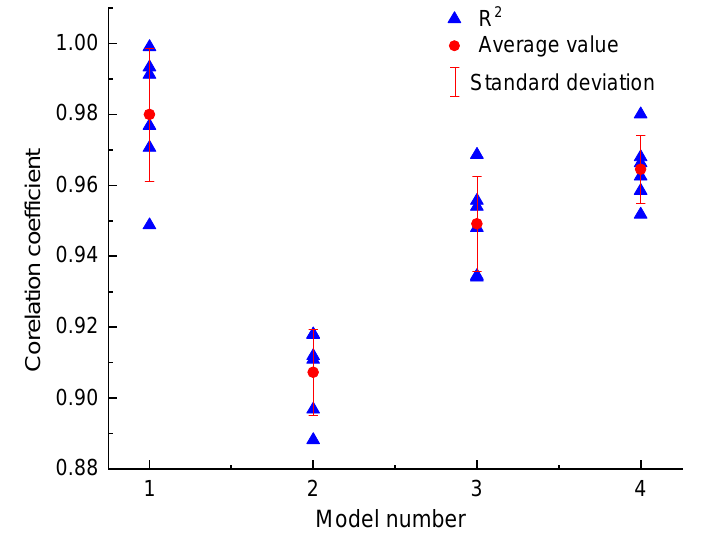
Figure 10. Fitting curves with four functions for based on in situ shear test data. ( a ) Asymmetric sigmoid function; ( b ) symmetric sigmoid function; ( c ) exponential function; ( d ) power function.